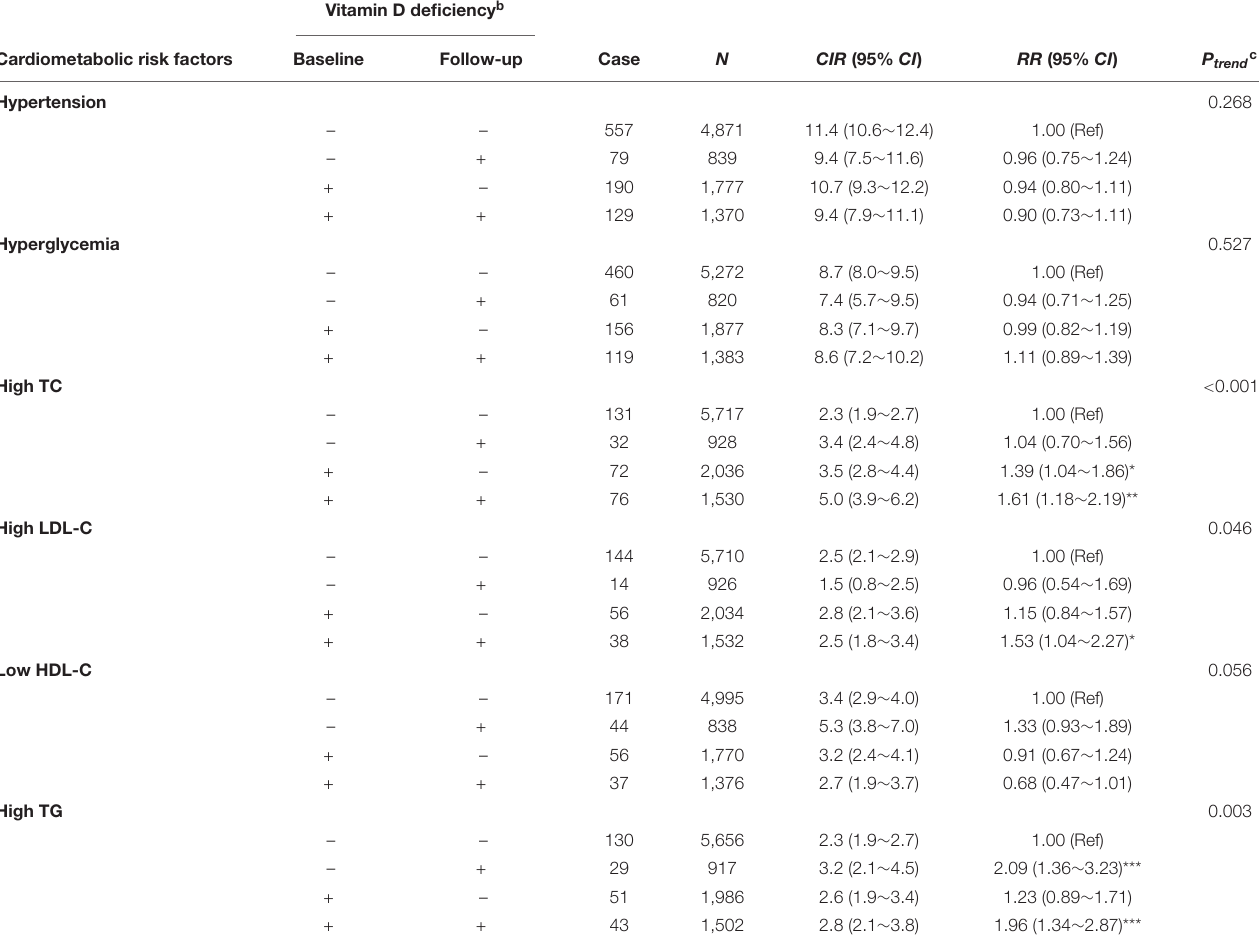
TABLE 2 | Multivariate adjusted risk ratios (95% CI ) a of cardiometabolic abnormities according to the longitudinal trajectory of vitamin D status from baseline to